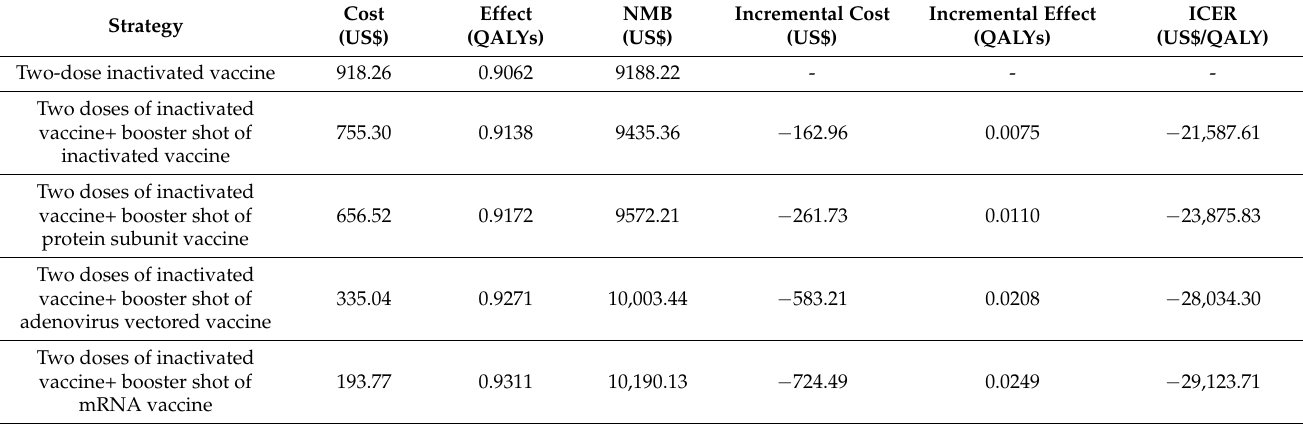
Table 2. Cost-effectiveness analysis of different sequential vaccination strategies compared with two-dose inactivated